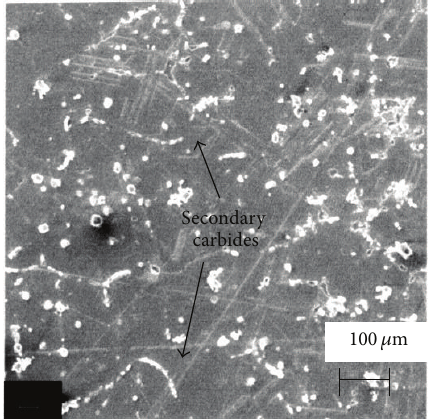
Figure 7: Precipitated carbides in grain boundaries of FSX-414 superalloy at intermediate temperature zone (area